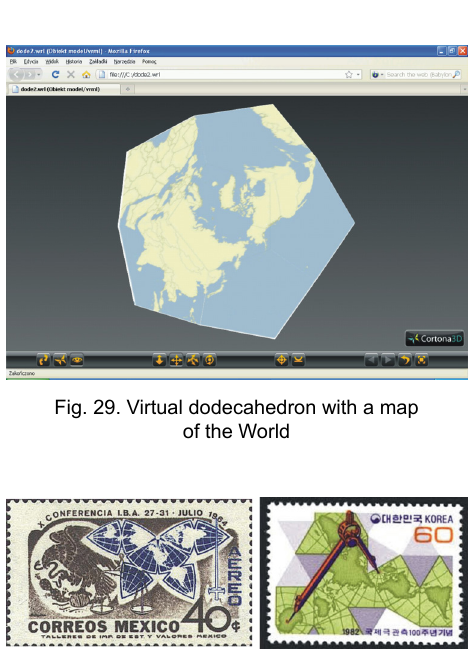
Fig. 30. Polyhedral maps on post stamps (source: portal